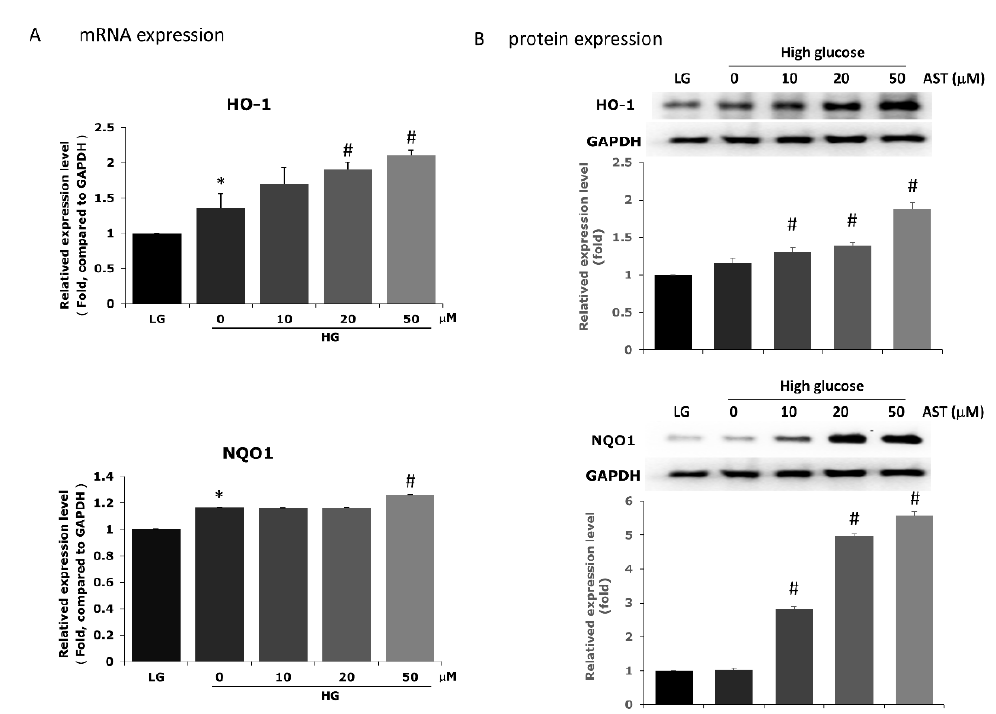
Figure 4. AST promotes the expression of Phase II enzymes HO-1 and NQO1 in 661W cells. The expression of HO-1 and NQO1 was determined in AST-treated 661W cells by measuring the mRNA levels with qPCR ( A ) and the corresponding protein levels by western blot ( B ). The measurements were normalized to GAPDH. AST = astaxanthin; HO-1 = Heme oxygenase-1; HG = high glucose; LG = low glucose; NQO1 = NAD(P)H dehydrogenase. * Significantly different from control group ( p < 0.05); # significantly different from high glucose-treated group without AST ( p < 0.05). The Mann–Whitney U test was used to calculate the differences between the means of different experimental groups.